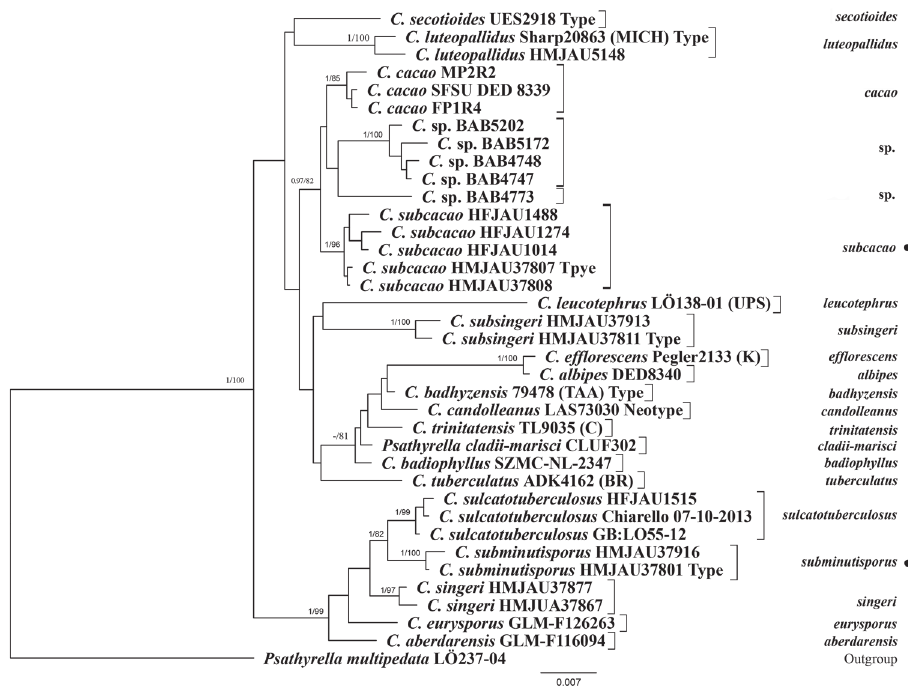
Figure 1. Phylogenetic tree of Candolleomyces . The tree was generated by Bayesian analysis of a concat- enated dataset of sequences from four nuclear regions (ITS, LSU, tef-1 α and β -tub ). Psathyrella multipedata (Peck) A.H. Sm. was used as an outgroup. Bayesian posterior probabilities (BI-PP) ³ 0.95 and Maximum Likelihood bootstrap support values (ML) ≥ 75% are shown above nodes as BI-PP/ML. ● indicates newly-described